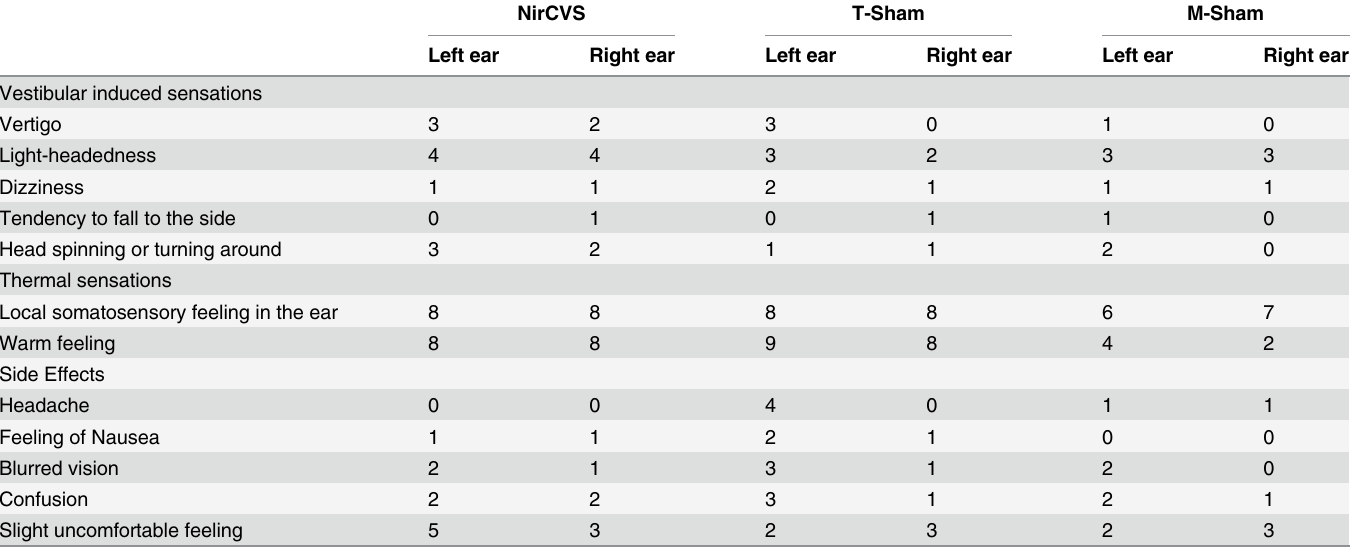
Table 1. Vestibular sensations